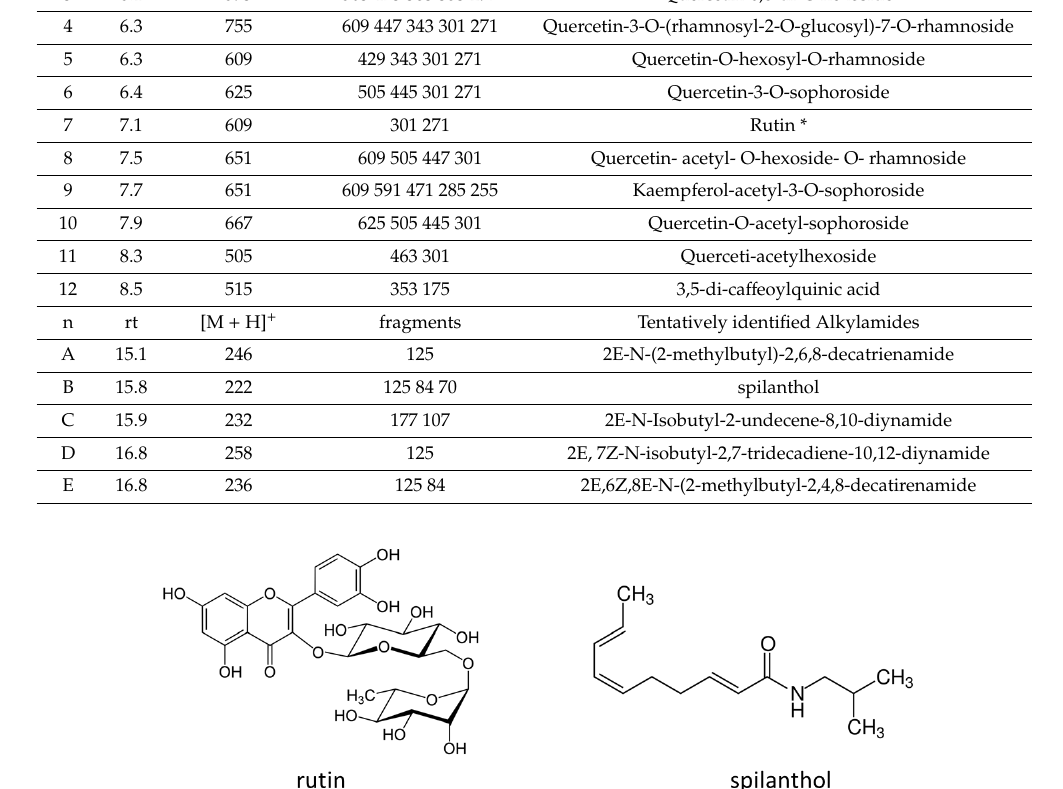
Figure 6. Chemical structure of rutin and spilanthol.